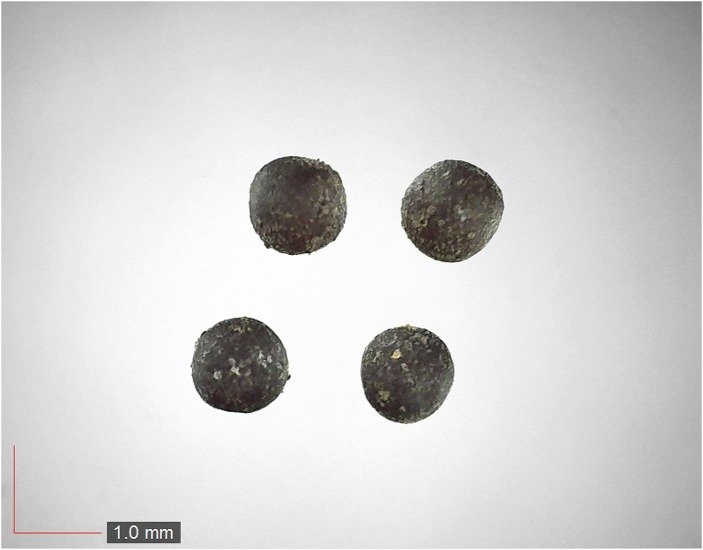
Unidentified 2.Table 2.